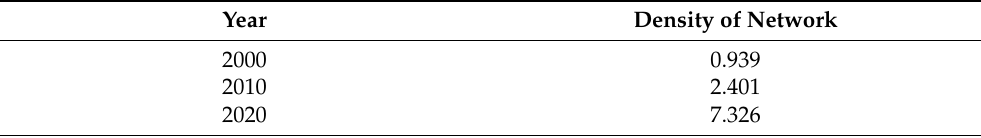
Table 6. The density value of the economic connection network of the Hexi Corridor city